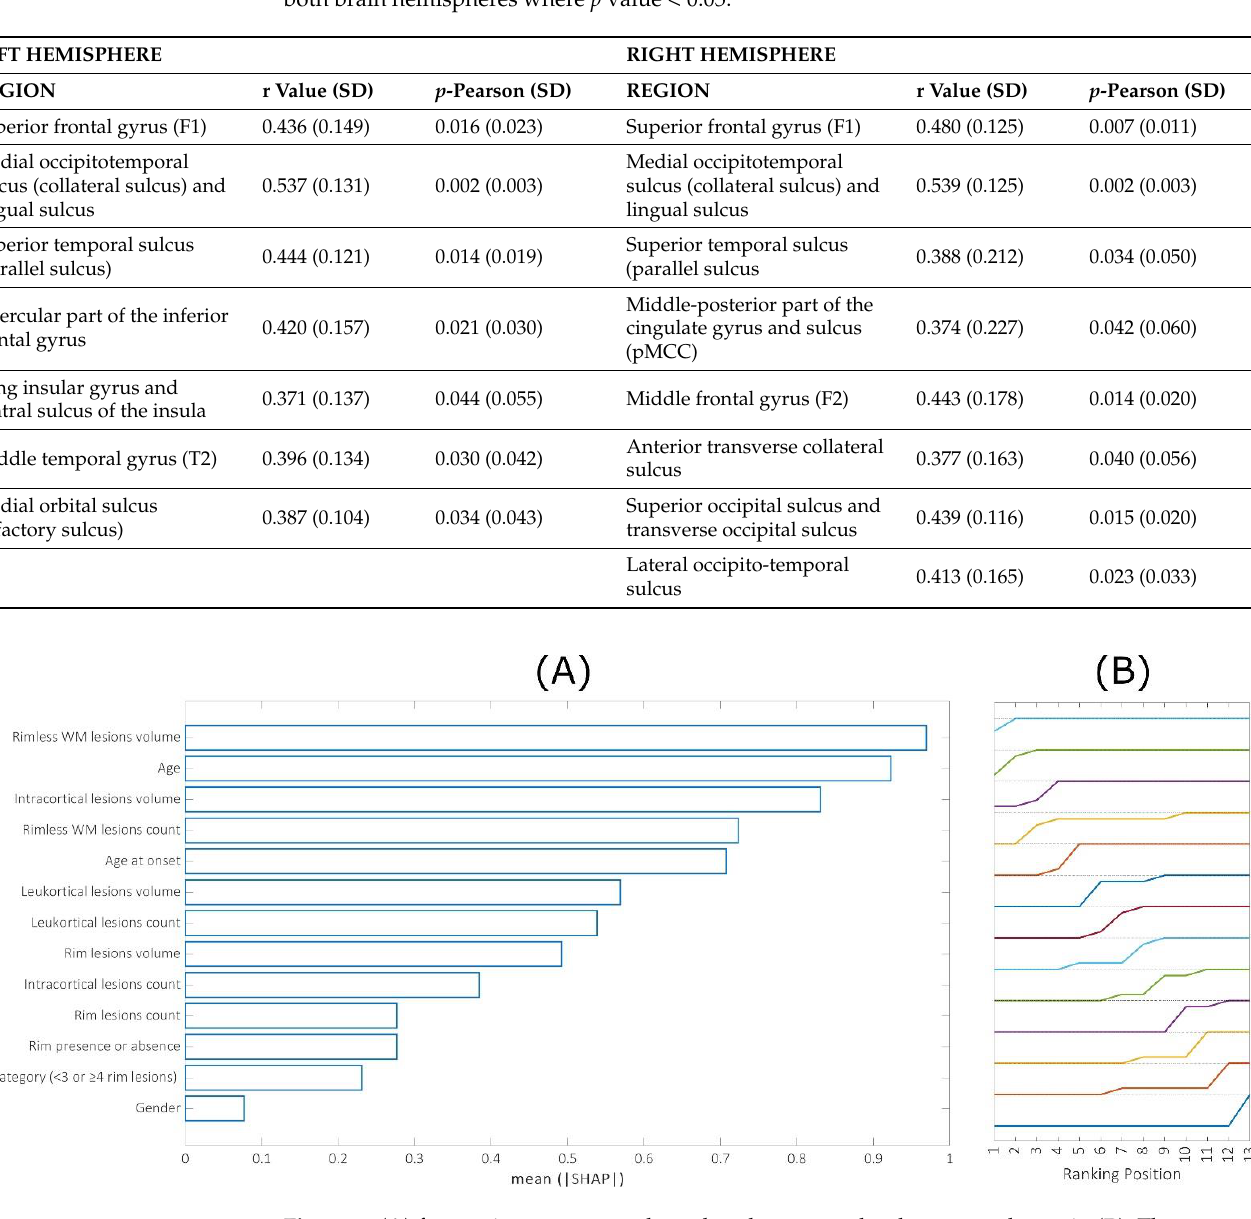
Figure 6. ( A ) feature importance evaluated as the area under the curves shown in ( B ). These curves were obtained by calculating the mean fraction of times (over 50 repetitions) each of the features appeared in each position in single-region rankings. Table 3. Pearson’s correlation (r) coefficients and corresponding p values evaluated between the real and predicted values in two different subject groups (G1, with a disease duration > 5 years and G2, disease duration < 5